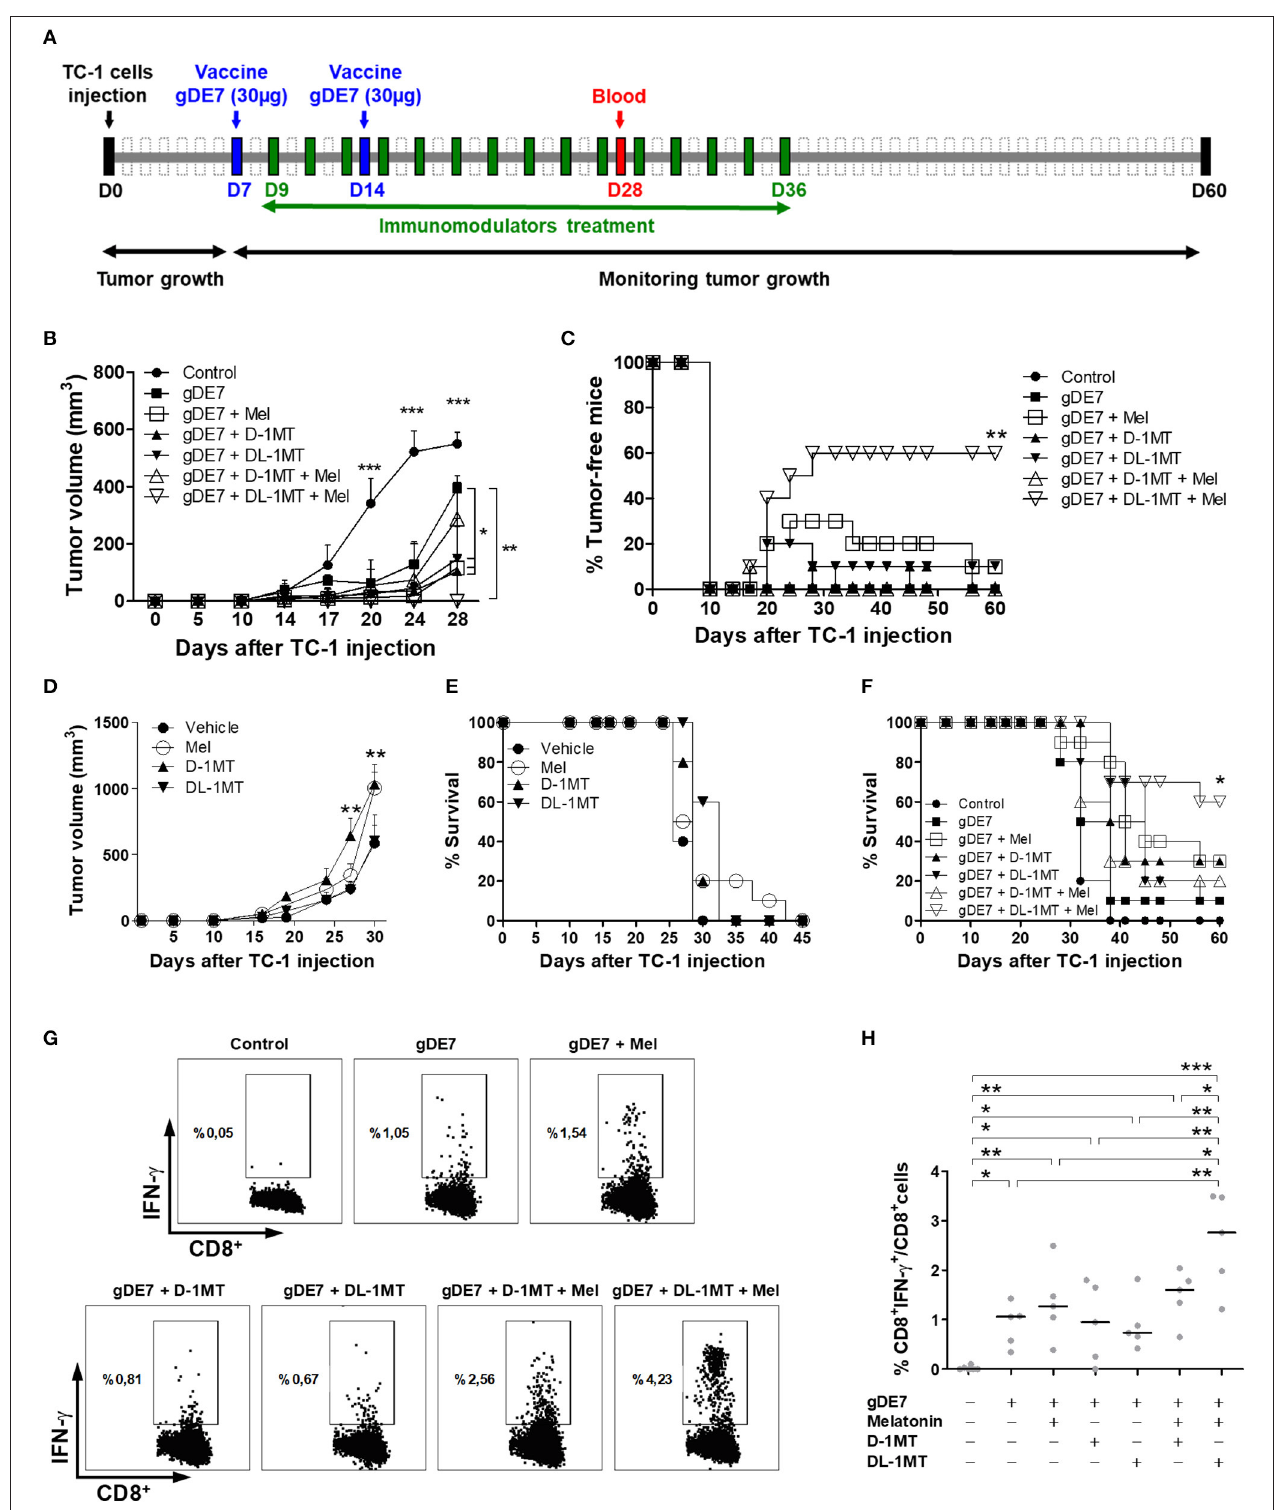
FIGURE 5 | Co-administration of melatonin and DL-1MT synergistically enhances the antitumor effects of gDE7-based vaccine in immunized mice. (A) WT mice were subcutaneously injected with 1 × 10 5 TC-1 cells and immunized with two doses (7-day interval) of gDE7 (30 µ g per animal) via the s.c. route (day